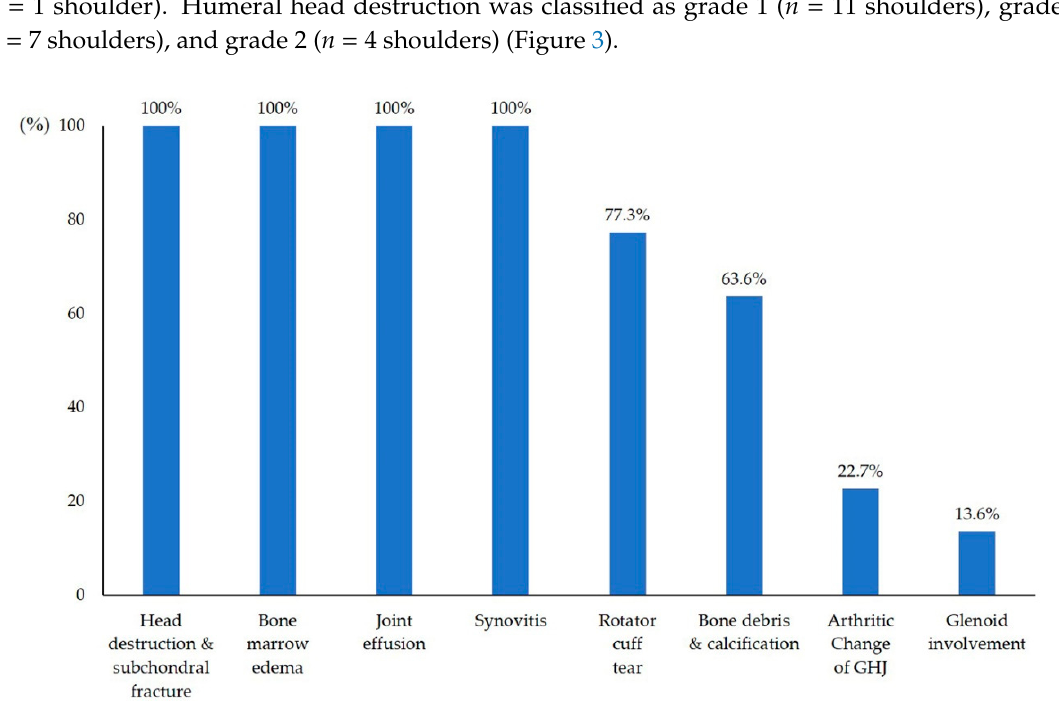
Figure 3. Diversity of humeral head involvement and destruction. ( a ) Case 8 (grade 1 involvement, grade 1 destruction). ( b ) Case 7 (grade 2, grade 1). ( c ) Case 11 (grade 2, grade 1). ( d ) Case 19 (grade 3, grade 3). ( e ) Case 16 (grade 3, grade 2). ( f ) Case 14 (grade 3, grade 3). ( g ) Case 21 (grade 3, grade 3). ( h ) Case 22 (grade 3, grade 3). The mean WBC count, neutrophil count, ESR, and CRP were 7395/µL (normal range 4000– 10,000/µL), 66% (normal range 38–73%), 31.1 mm/h (normal range 0–30 mm/h), and 0.72 mg/L (normal range 0–0.5 mg/L), respectively. No growth of pathogens or crystals was observed in aspirated joint fluid analysis and intraoperative tissue culture. Intraoperatively, resected humeral heads were collapsed with detached articular cartilage. In cases of severe head destruction, articular surfaces were flat and covered by fibrous tissues. Histologically, slender bone trabeculae were identified, and bone marrow was replaced by fat tissue. There was evidence of partial osteoid formation admixed with multinucleated osteoclasts in the